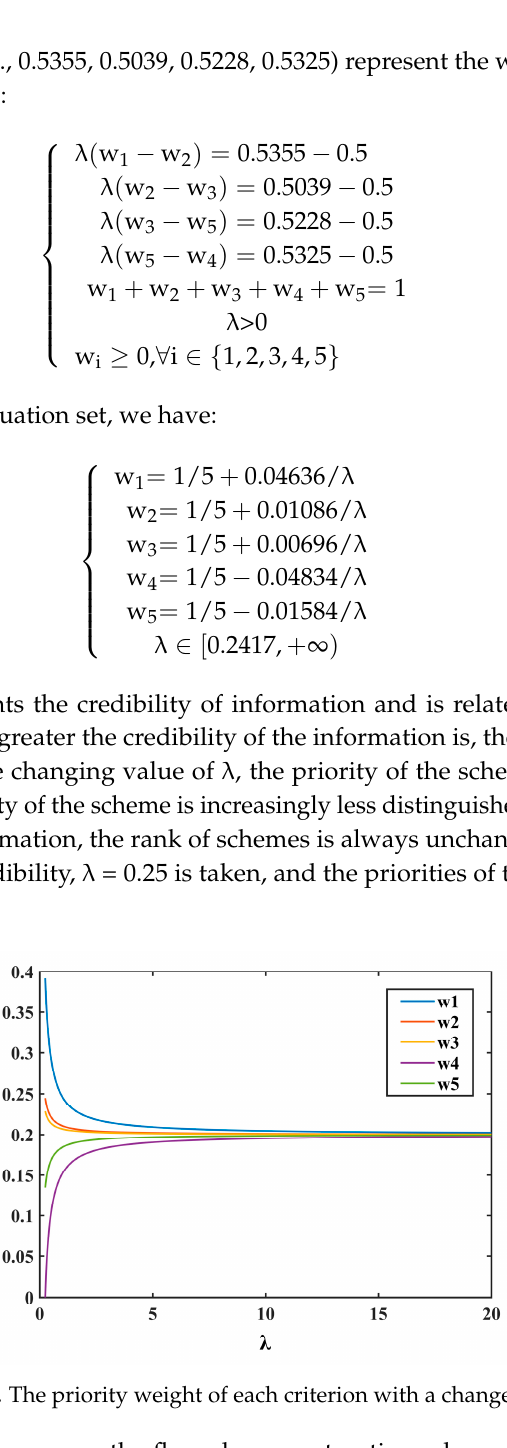
Figure 10. Results of the flow shop construction scheme MCDM. ( a ) Optimal flow shop at Elevation 2587–2617; ( b ) Optimal flow shop at Elevation 2617–2707; ( c ) Optimal flow shop at Elevation 2707– 2767; ( d ) Optimal flow shop at Elevation 2767–2794; ( e ) Optimal flow shop at Elevation 2794–2869; ( f ) Optimal flow shop at Elevation 2869–2902;.